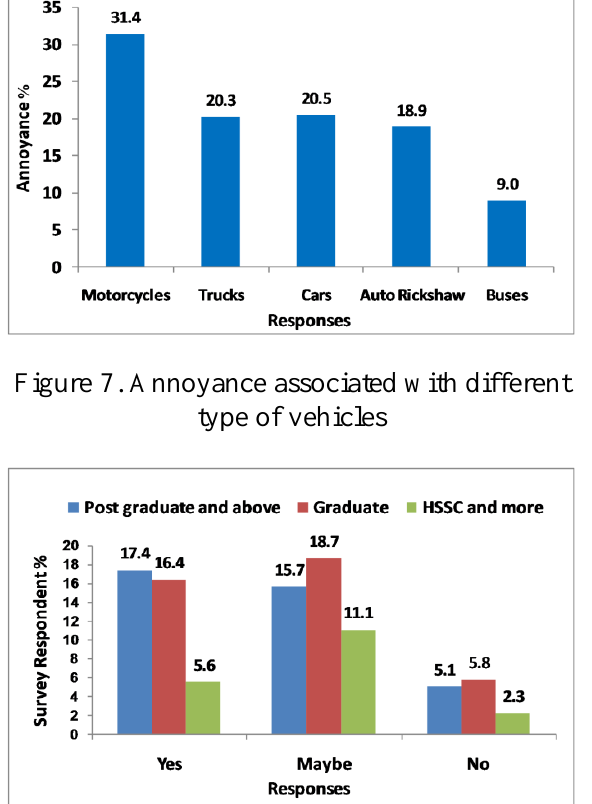
Figure 6. Noise annoyance percentage levels